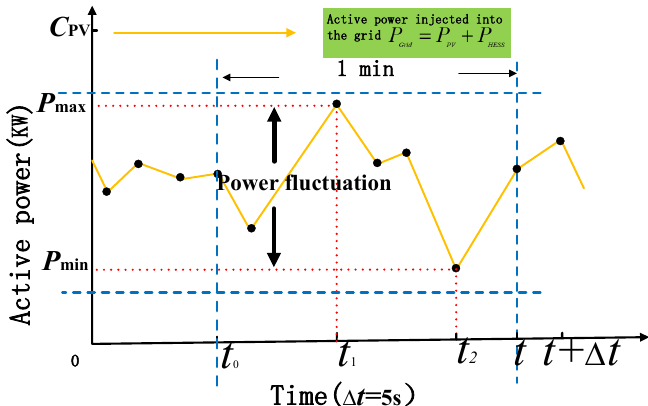
Figure 1. PV power fluctuations in one minute. The comparison of typical daily PV output and wind output curve and actual load curve in a certain place is shown in Figure 2.